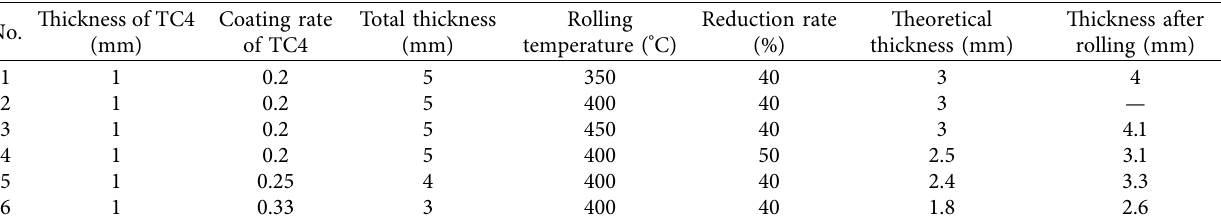
Figure 7: The Al-Ti-Al laminated plate. (a) Before rolling. (b) After rolling. Table 5: Rolling parameters of the laminated